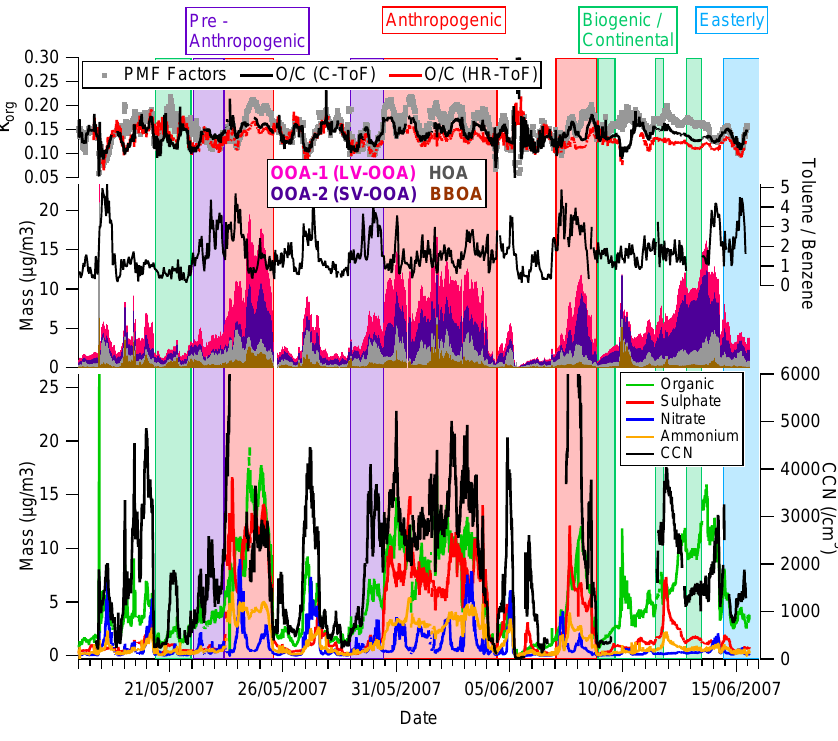
Fig. 3. Time series in local time of κ org calculated from PMF factors and O/C (top panel, see text for more detail), toluene/benzene (black trace in middle panel), PMF factors (middle panel, note that these are cumulative), and aerosol chemical measurements measured by the AMS and CCN concentrations (bottom